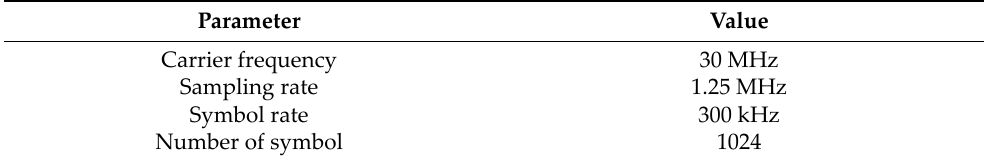
Table 4. Modulation.